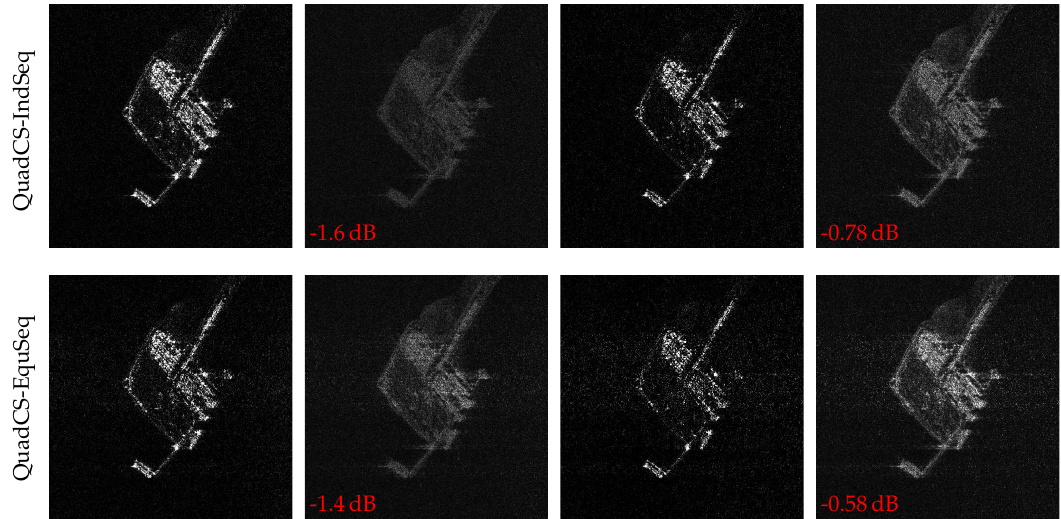
Figure 7. Recovery of the TerraSAR-X SLC image. From top to bottom: QuadCS-IndSeq, QuadCS-EquSeq, Xampling. From left to right: recovered images and corresponding residuals with compression ratios 1/8 and 1/16. Range and azimuth are along the horizontal and vertical axes, respectively. The relative errors for these images are shown at the lower left corners of their residual images, respectively. For the sparse scene, QuadCS-IndSeq achieves − 5.7 dB even at the compression ratio 1/16.